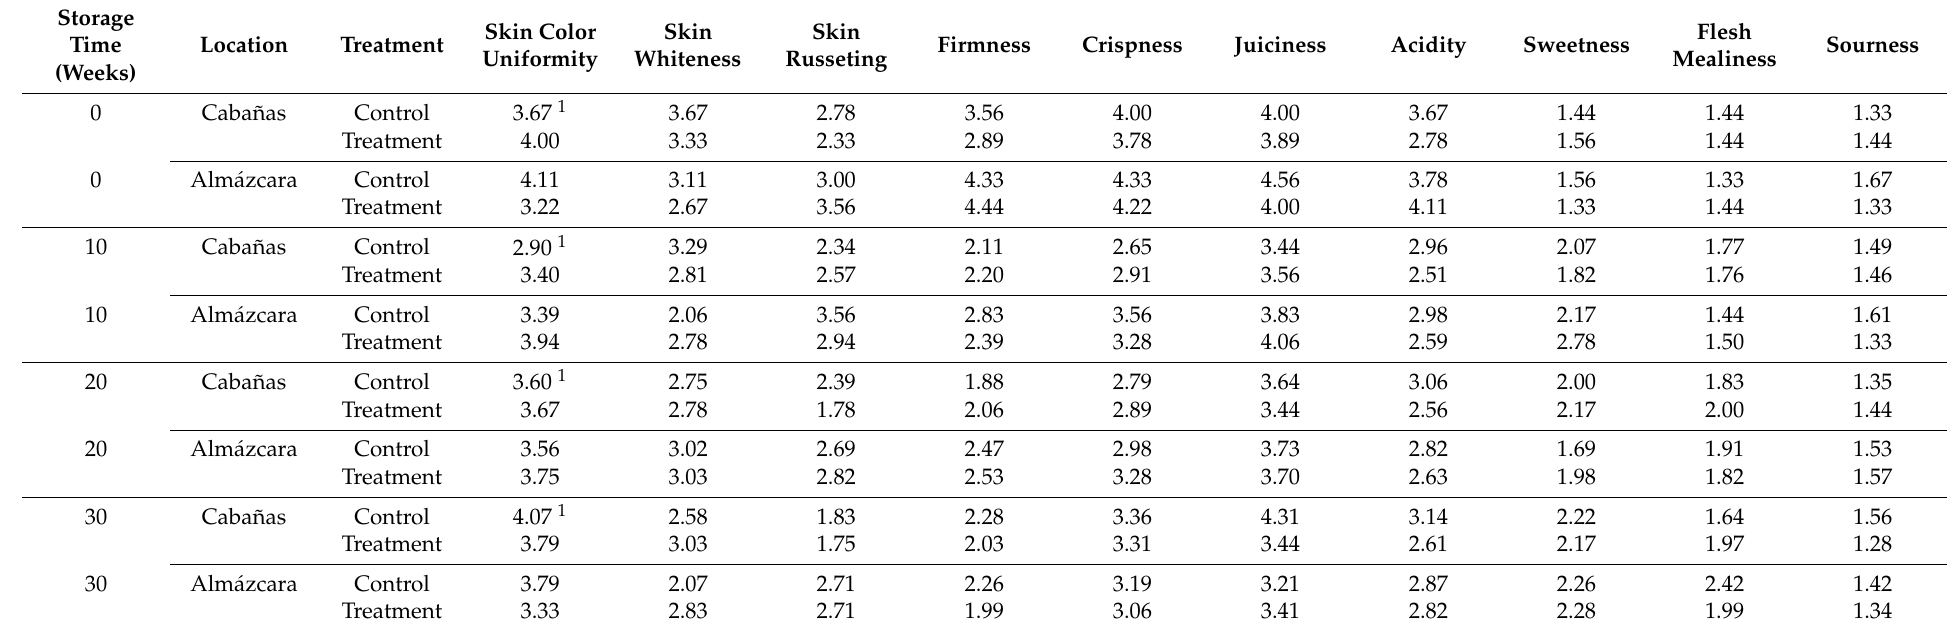
Table 6. Effect of pruning on sensory quality attributes of apple cv. ‘Reinette du Canada’ at harvest and during